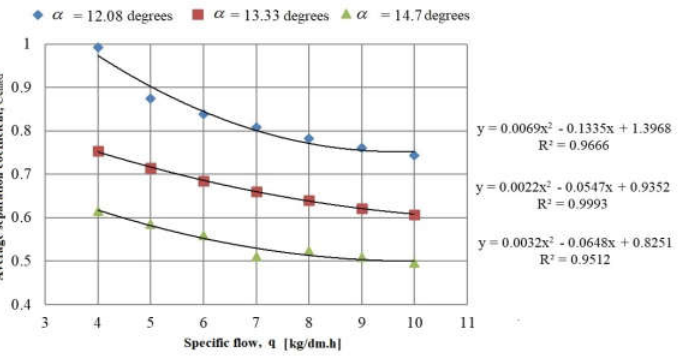
Figure 6. Variation in separation coefficient for nettle according to the specific flow for n = 1000 rpm. For the speed of the drive mechanism n = 1000 rpm ( k = 5.59) and constant specific flow q = 4 kg/dm · h, the average separation coefficient for nettle was Ce med = 0.922 for α = 12.08 ◦ , Ce med = 0.753 for α = 13.33 ◦ , and Ce med = 0.616 for α = 14.7 ◦ . At higher specific flows, the average separation coefficient